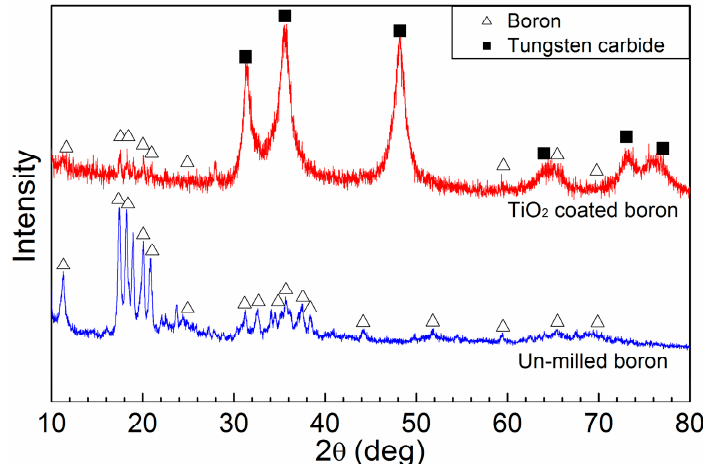
Figure 2. X-ray diffraction (XRD) patterns of the 8 h-wet milled TiO 2 -coated boron particles (top) and un-milled boron particles (bottom).